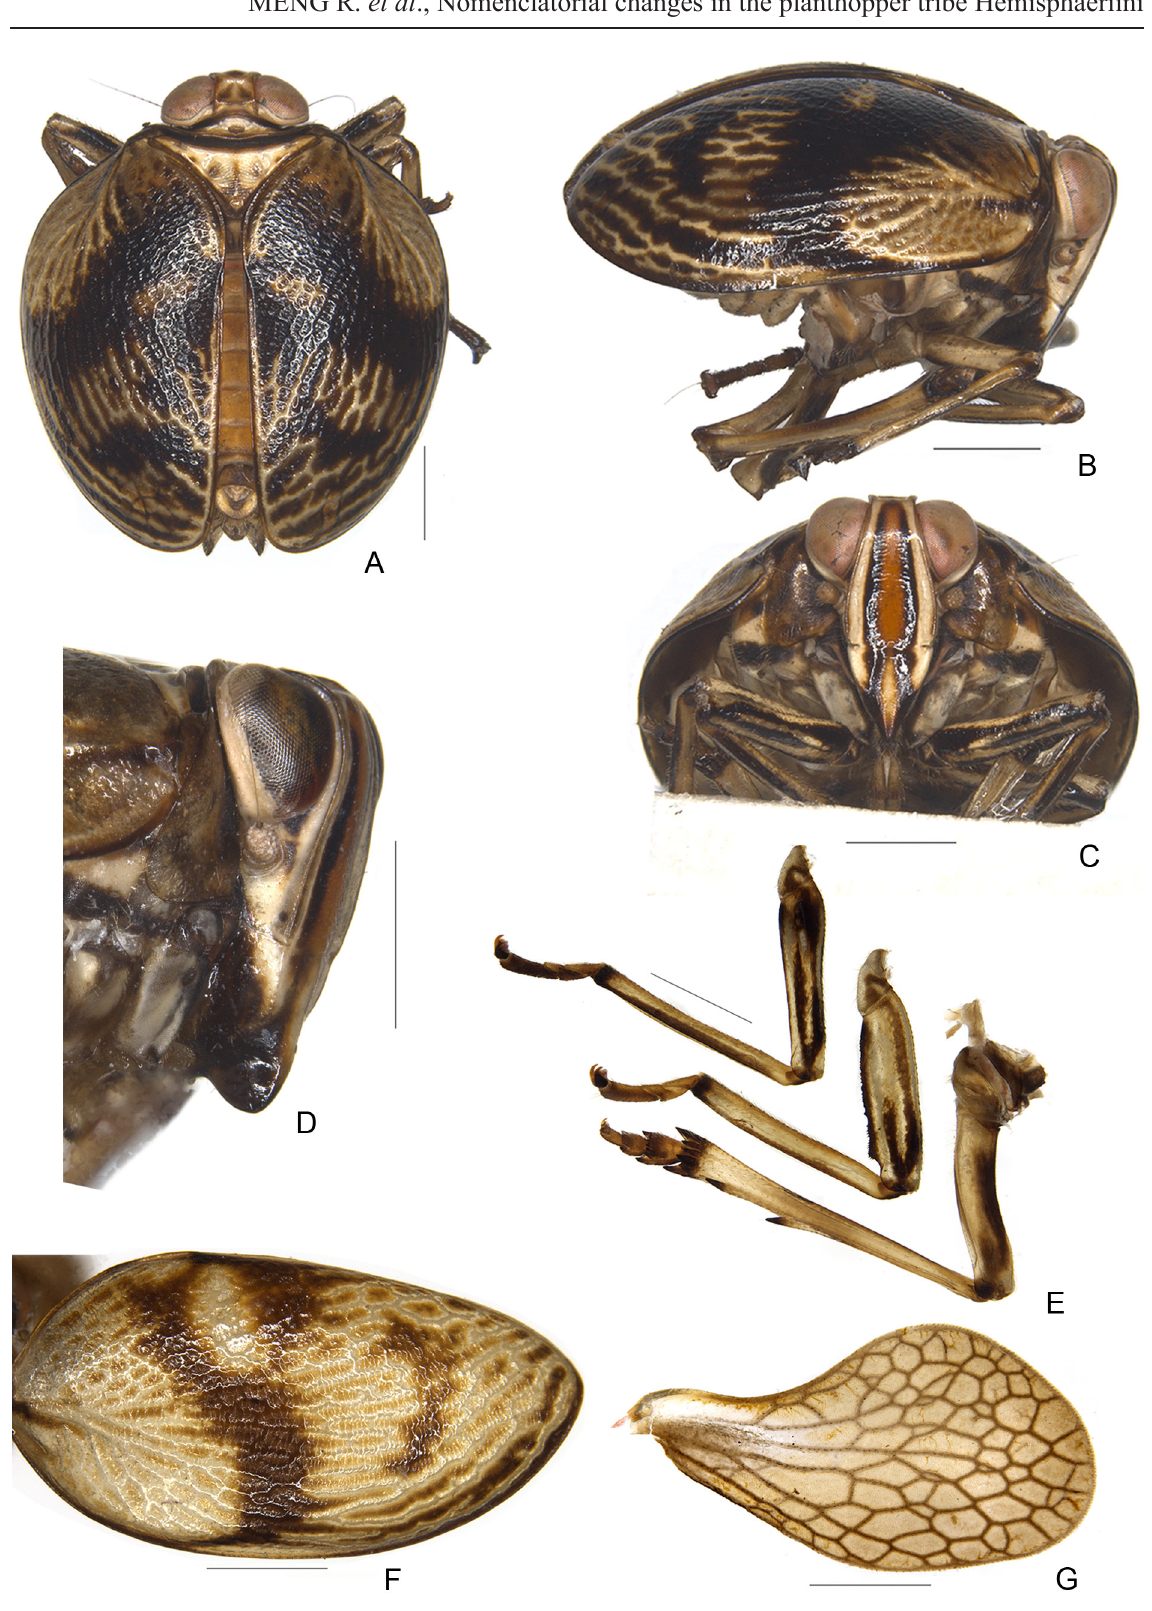
Fig. 2. Gergithus frontilongus sp. nov. A . Habitus, dorsal view. B . Habitus, lateral view. C . Metope and clypeus, facial view. D . Metope and clypeus, lateral view. E . Fore leg, mid leg, hind leg. F . Tegmen. G . Hind wing. Scale bars =